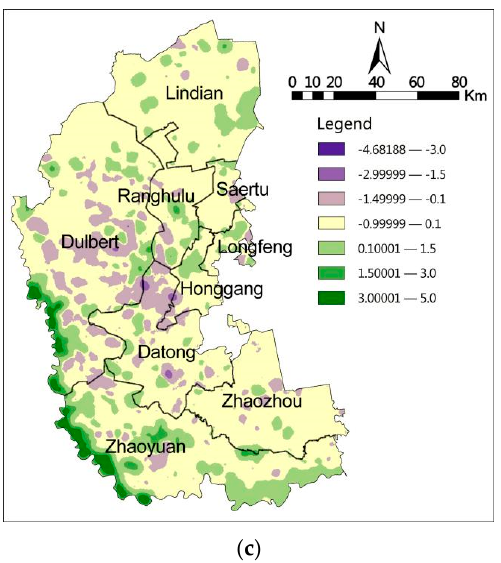
Figure 6. Changes in the amount of hemeroby in the whole study area: (a) In the period of 1990-2000;